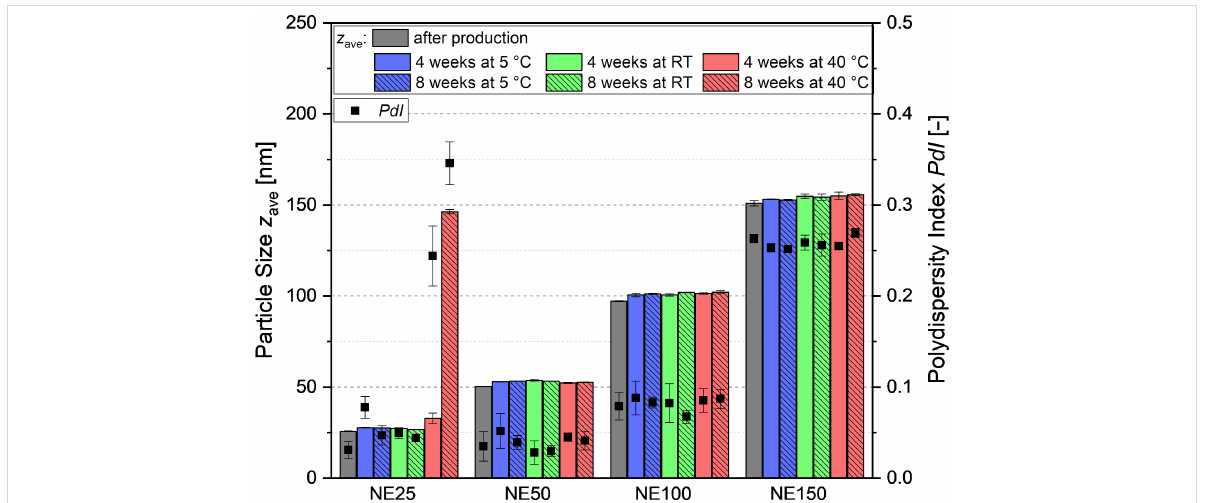
Figure 6: Long-term stability of four selected nanoemulsions with particles of approximately 25 (NE25), 50 (NE50), 100 (NE100) and 150 nm (NE150) in diameter at the recommended storage conditions according to the ICH guidelines Q1A of 5 ± 3 °C, room temperature (RT) and 40 ± 2 °C.